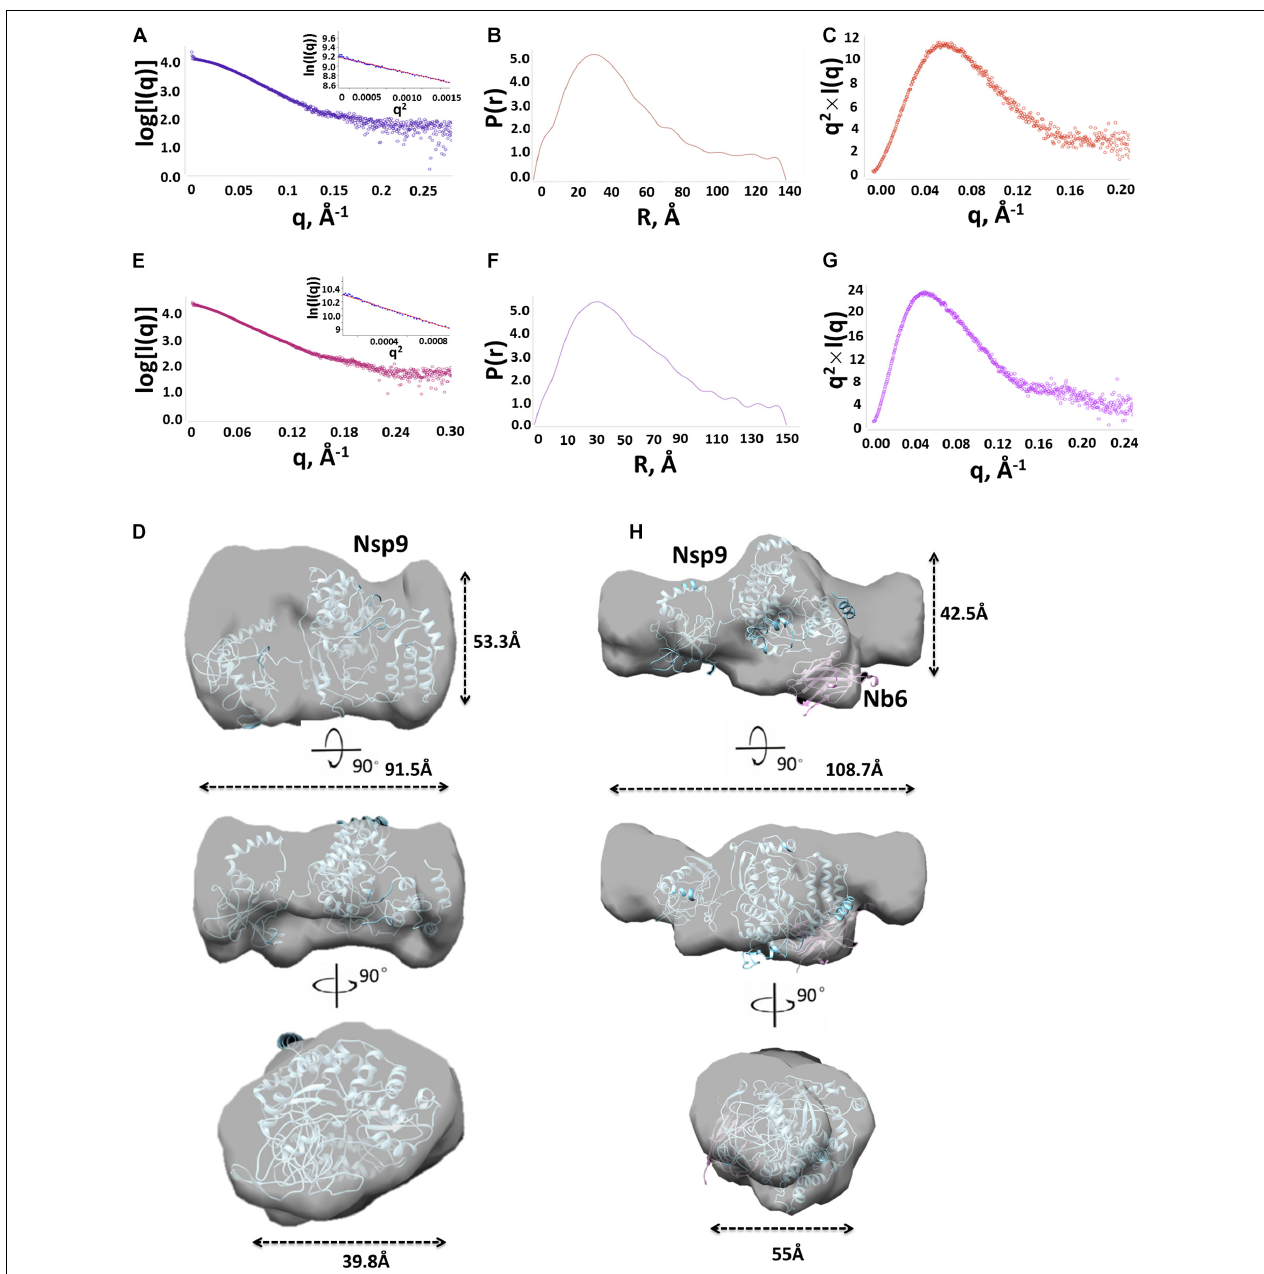
FIGURE 3 | Structural characterization of Nsp9 and Nsp9-Nb6 complex by SAXS. (A) Experimental SAXS curve (open circles) of Nsp9 in solution. The Guinier region and the corresponding linear fitting were shown in the inset. (B) Pair-distance distribution function derived from the experimental curve. (C) Kratky plot calculated from the experimental data. Bell shaped curves indicate compact structures. (D) Superimposition of the experimental envelope (as shown in surface) onto the model of Nsp9 represented in cartoon. (E) Experimental SAXS curve (open circles) of Nsp9-Nb6 complex in solution. The Guinier region and the corresponding linear fitting were shown in the inset. (F) Pair-distance distribution function derived from the experimental curve. (G) Kratky plot calculated from the experimental data. Bell shaped curves indicate compact structures. (H) Superimposition of the experimental envelope (as shown in surface) onto the heterogeneous model of Nsp9 and Nb6 heterodimer represented in